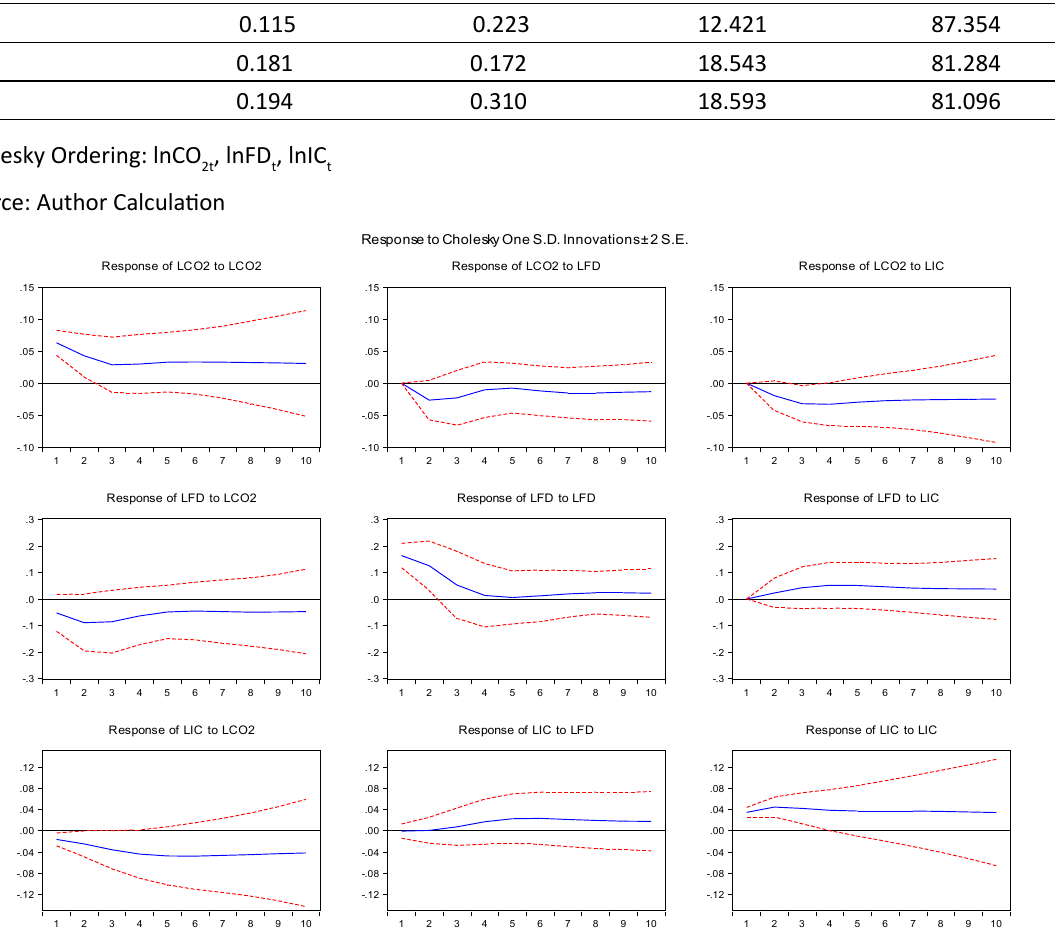
Figure 4: Impulse Response Analysis